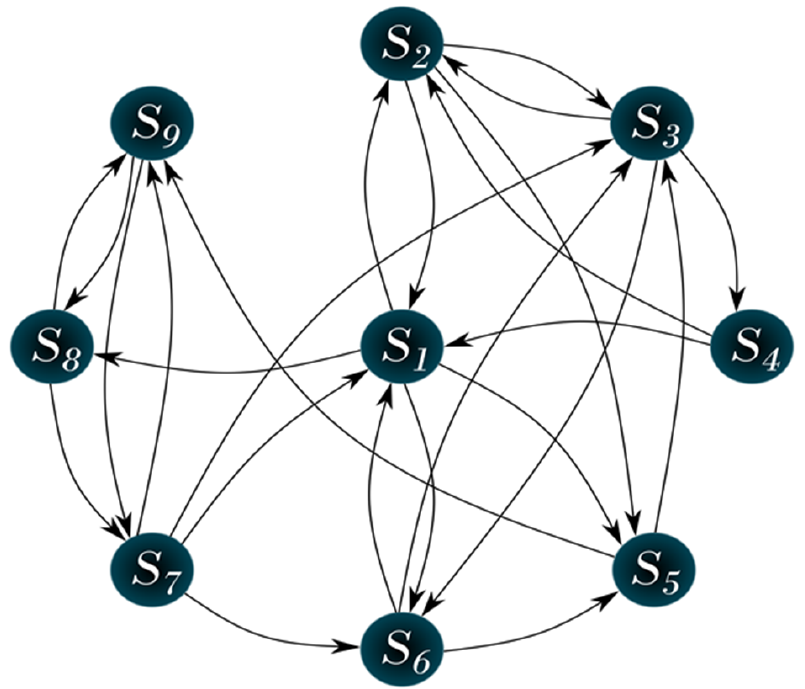
Figure 3. Transition diagram for nine-state semi-Markov model of light utility vehicle operations process.